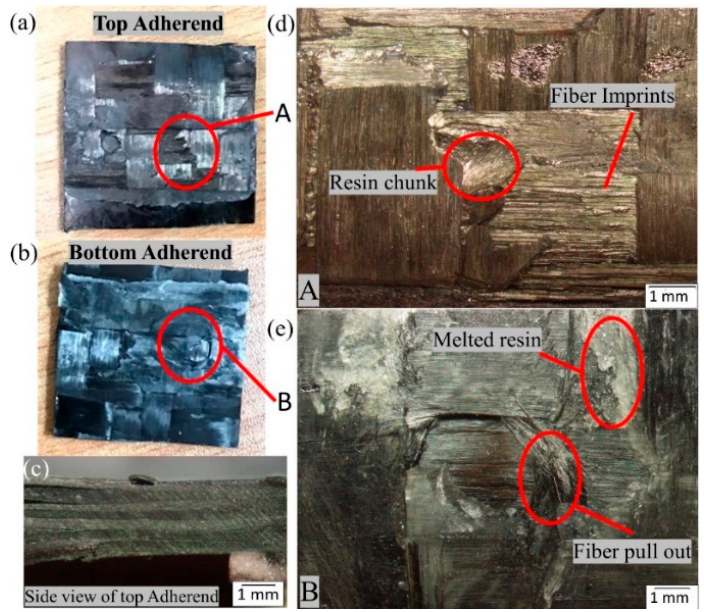
Figure 15. Fracture surfaces of SC-ELC_2SC-ELC specimen with maximum lap shear strength (LSS) value.